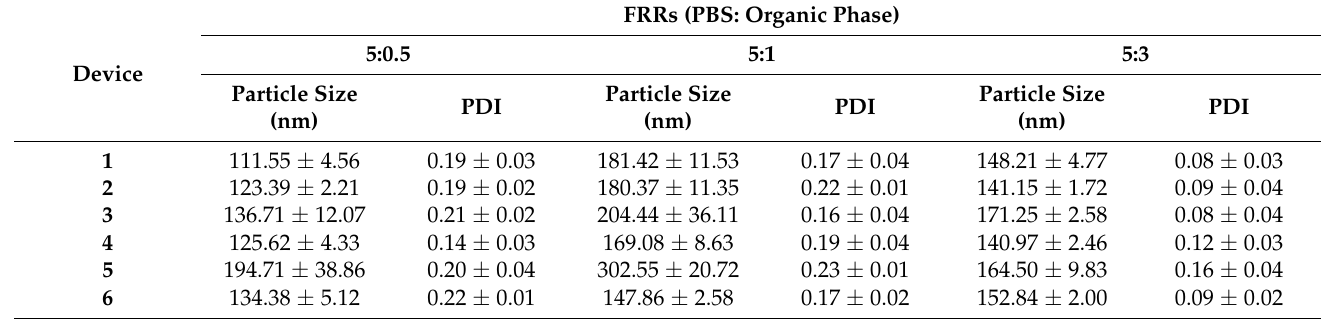
Table 2. Summary overview of obtained data by testing all devices with several FRRs. One- way ANOVA analysis was performed adhering to a p value ≤ 0.05. In accordance with the re- sults, comparing all devices for each FRRs, it was found that there was a significant difference ( p value < 0.0001). Comparing each device for all FRRs, it was found that there was a statistical difference ( p value < 0.0001) for all devices. Results represent mean ± SD, n = 3 independent